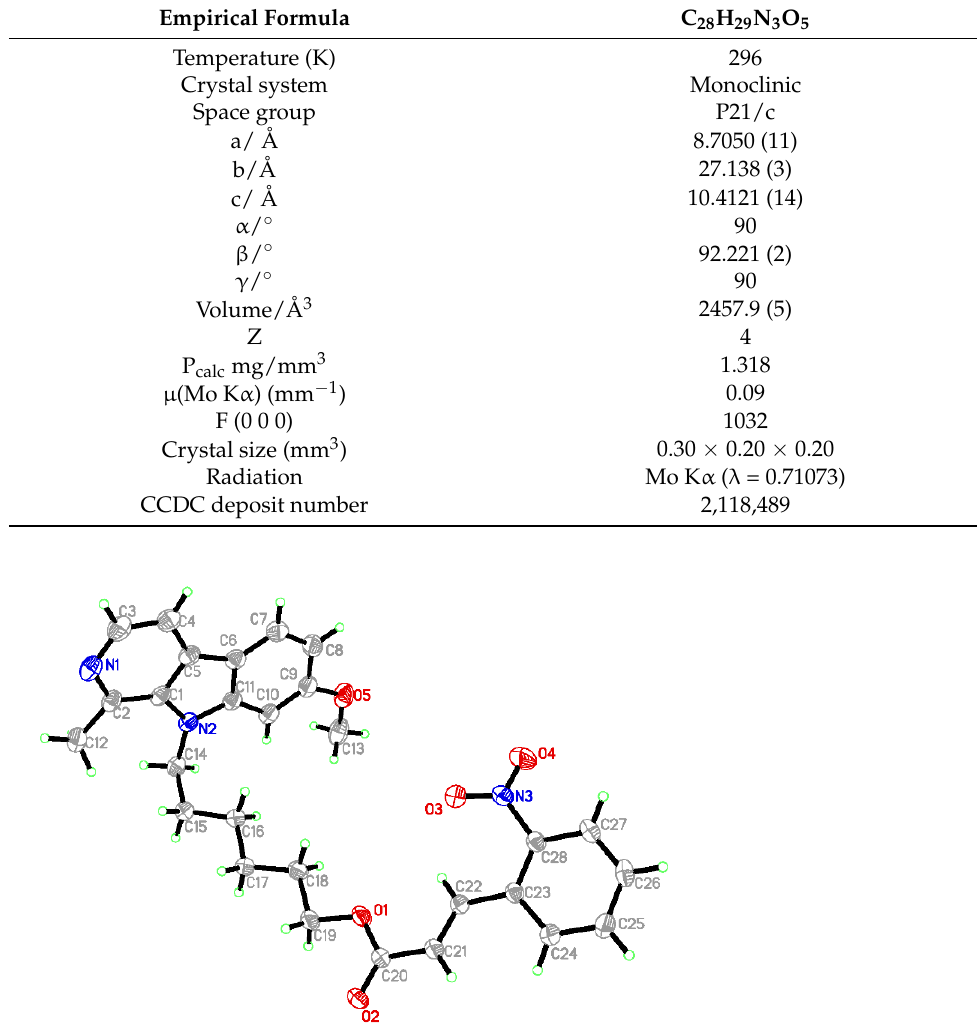
Figure 3. Spatial structure of compound 7l .